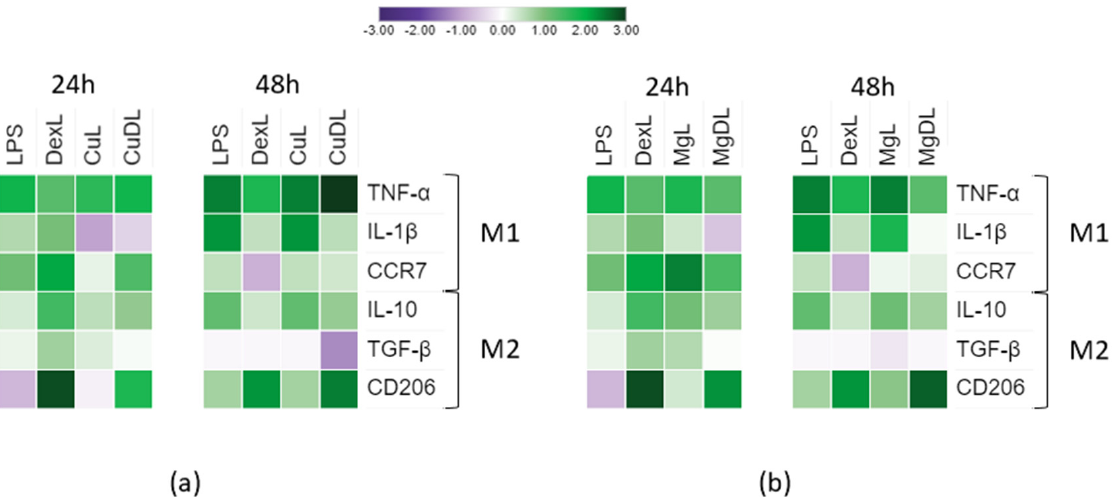
Figure 6. Effect of dex and the combination of dex with Cu 2+ and Mg 2+ on the expression of M1 and M2 in LPS-activated THP-1 macrophage cell line. ( a ) Gene expression after incubating LPS-activated macrophages with Cu 2+ (CuL) and the combination of Cu 2+ with dex (CuDL). ( b ) Gene expression after incubating LPS-activated macrophages with Mg 2+ (MgL) and the combination of Mg 2+ with dex (MgDL). After 24 or 48 h of incubation, total RNA was extracted and the mRNA levels of three M1 markers (TNF- α , IL-1 β and CCR7) and three M2 markers (IL-10, TGF- β and CD206) were determined by RT-qPCR. Results were normalized against β -actin mRNA and are expressed relative to the mRNA levels of unstimulated THP-1 macrophages (TCP). The complete statistical analysis is in Tables S7–S12.